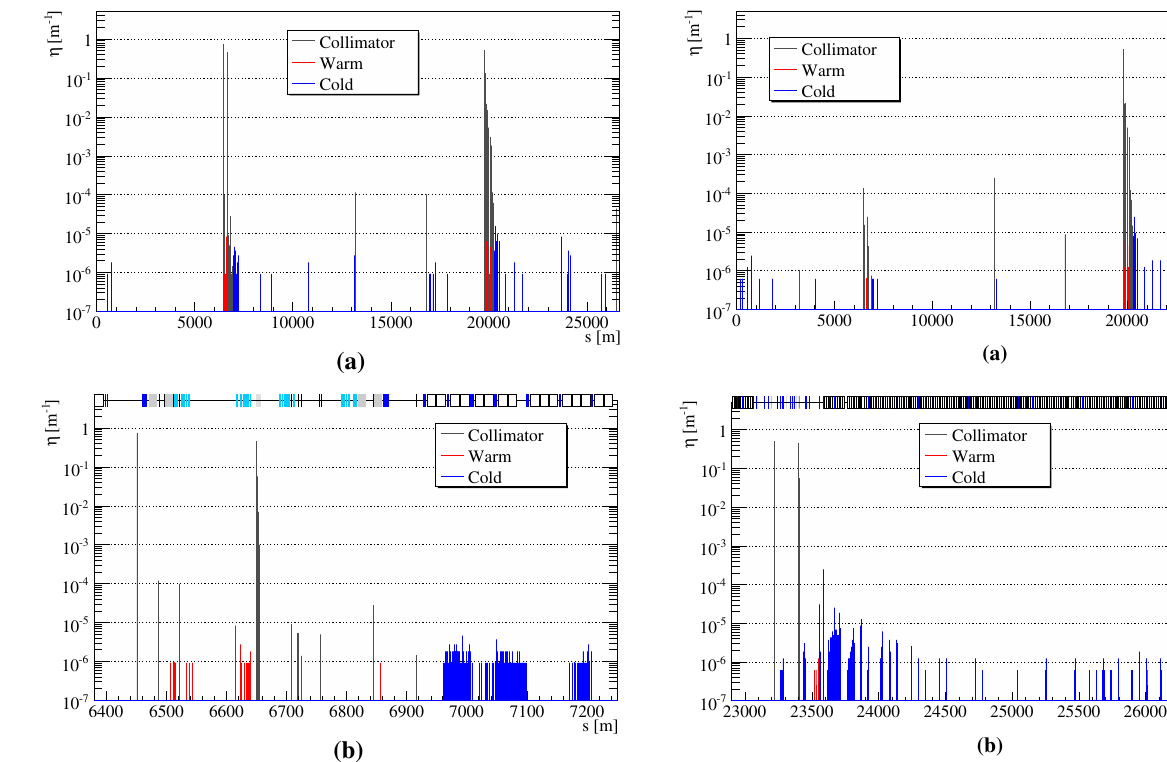
intercept off-momentum protons coming from the Cry 1 .